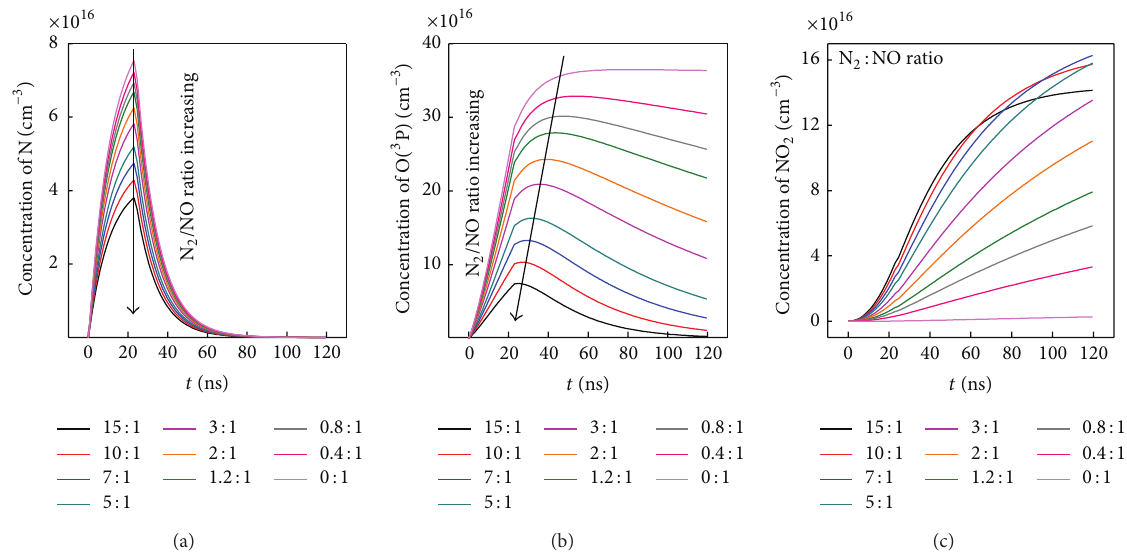
Figure 13: Concentration evolution versus time of (a) N atoms, (b) O( 3 P) atoms, and (c) NO 2 molecules under different N 2 /NO mixing ratio. The arrow direction represents the N 2 /NO mixing ratio